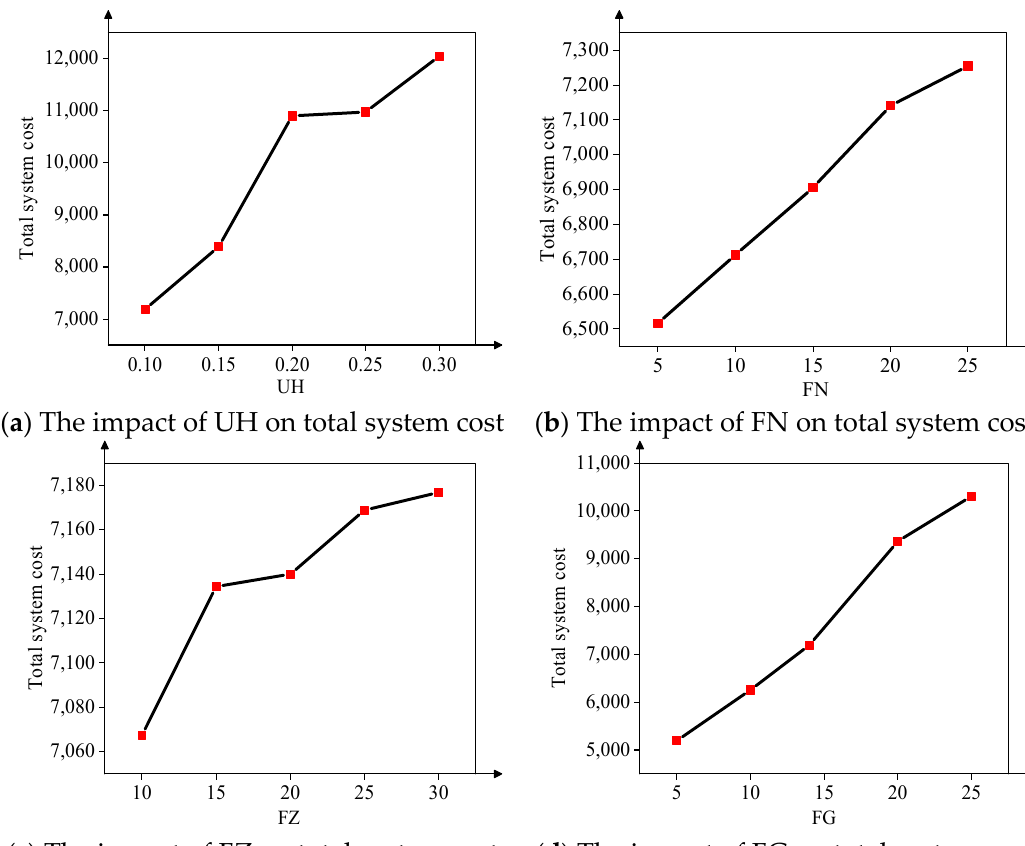
Figure 4. The impact of various parameters on the total system cost.